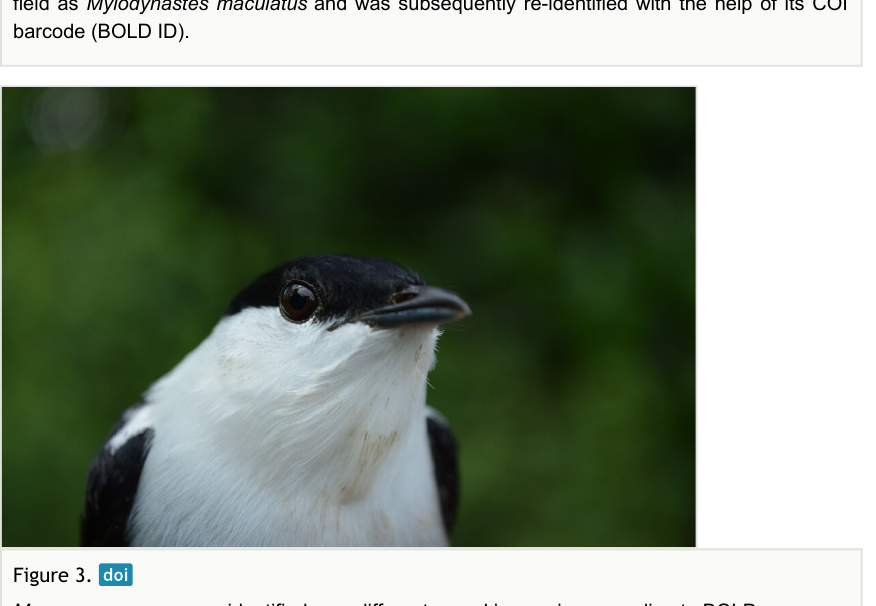
Manacus manacus was identified as a different manakin species according to